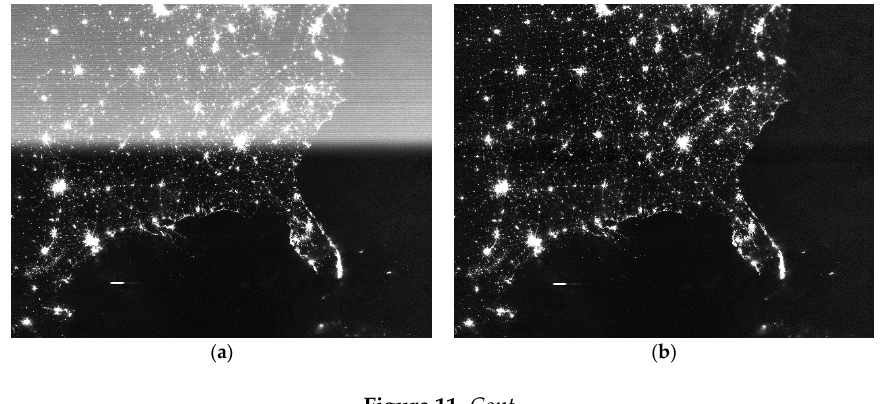
Figure 11. Cont. Figure 11.